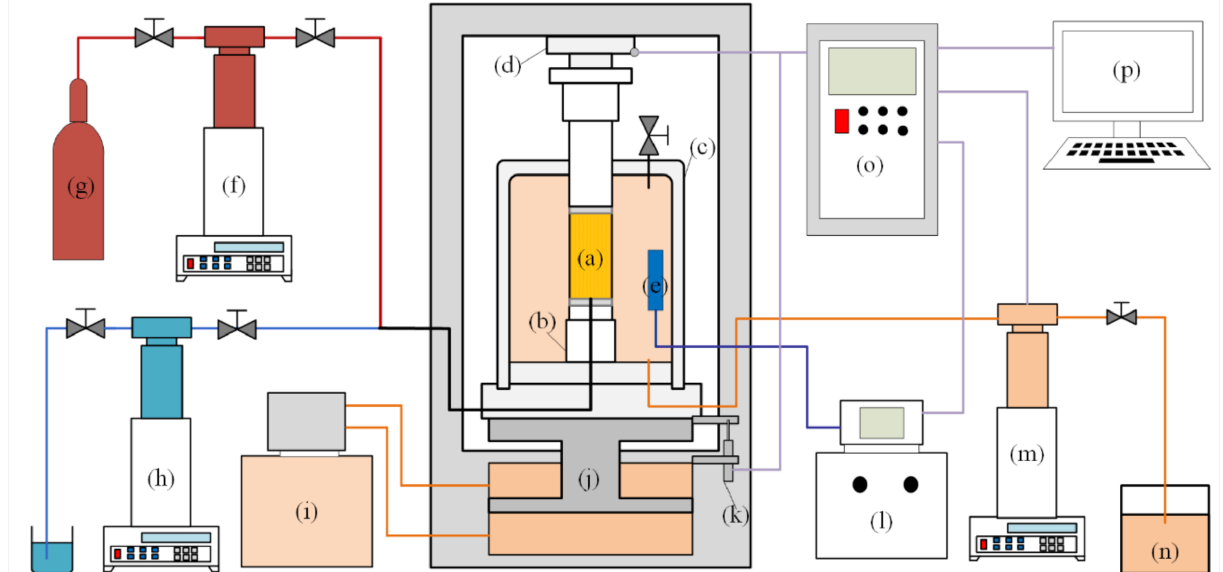
Figure 2. The schematic diagram of the low-temperature, high-pressure triaxial test system: ( a ) specimen, 61.8 (diameter) × 125 mm (height); ( b ) pedestal; ( c ) chamber; ( d ) load cell; ( e ) heat exchanger; ( f ) plunger pump (hydrate formation); ( g ) CH4 gas cylinder; ( h ) plunger pump (water saturation); ( i ) hydraulic oil source; ( j ) axial loading device; ( k ) LVDT; ( l ) circulation thermostatic water bath (sample temperature control); ( m ) plunger pump (confining pressure control); ( n ) oil tank; ( o ) data acquisition module; ( p )